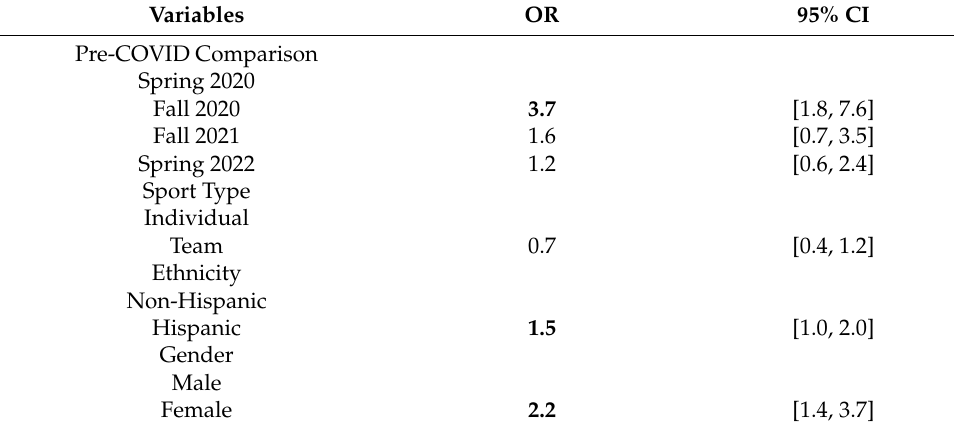
Table 3. Logistic regression analysis of predictors for scoring 3 or higher on